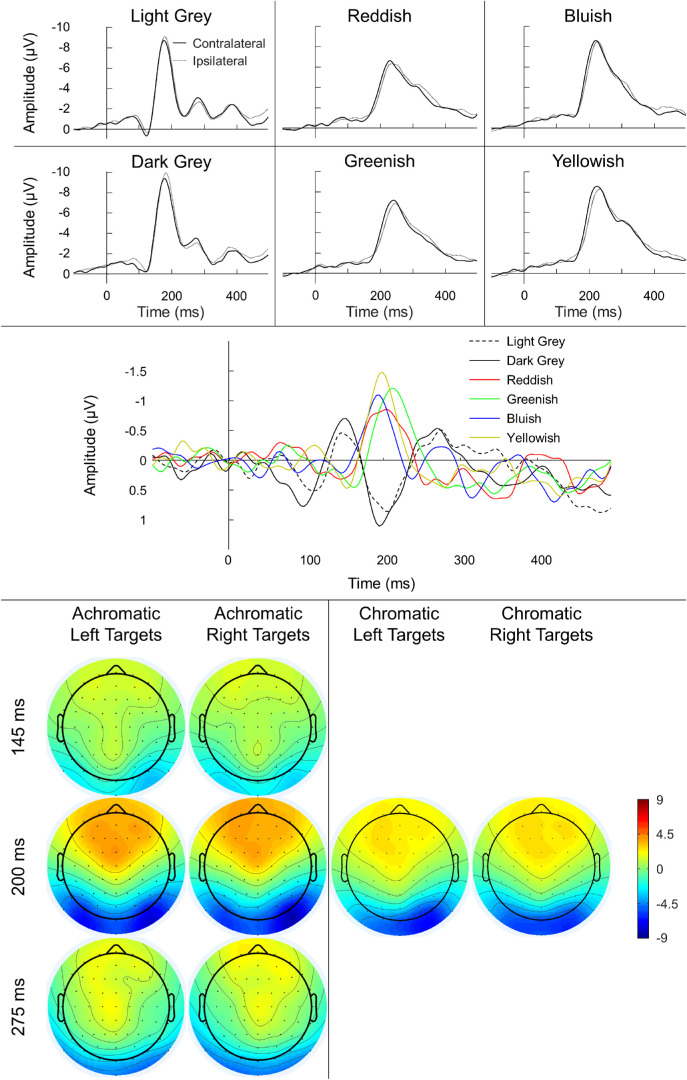
Grand-average contra- and ipsilateral waveforms (to the target location) at PO7/8 channels (top), grand-mean difference waveforms (calculated by subtracting ipsilateral from contralateral activity; middle) and topographical maps of ERPs (bottom) for the six conditions of Experiment 1. Negativity is plotted upward for the contralateral/ipsilateral and difference waveform graphs. Note the presence of three difference wave components for the achromatic conditions compared to the single component present for the chromatic conditions. The topographical maps represent the activity (in µV) across the entire scalp at latencies approximately equal to the peaks of three (achromatic conditions) and single (chromatic conditions) difference wave components.